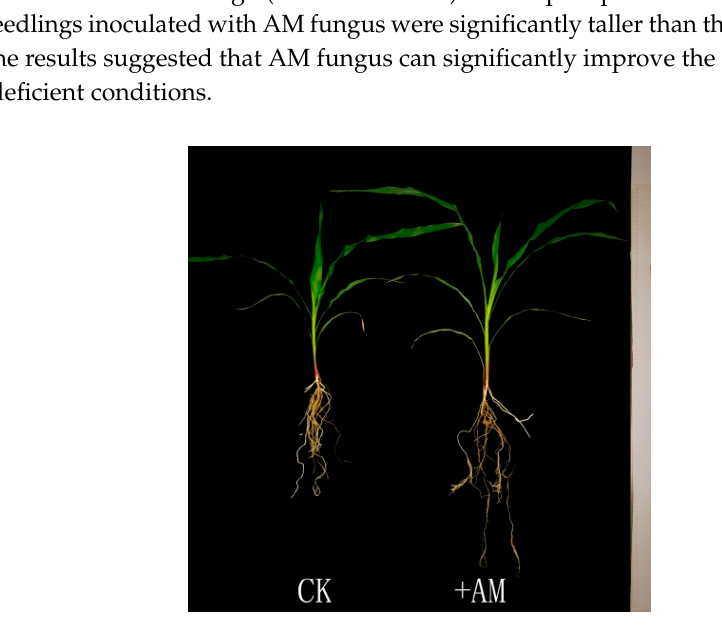
Figure 1. Influence of arbuscular mycorrhizal (AM) fungus on the growth of maize. CK, seedling without fungal inoculation; +AM, seedling inoculated with AM fungus.